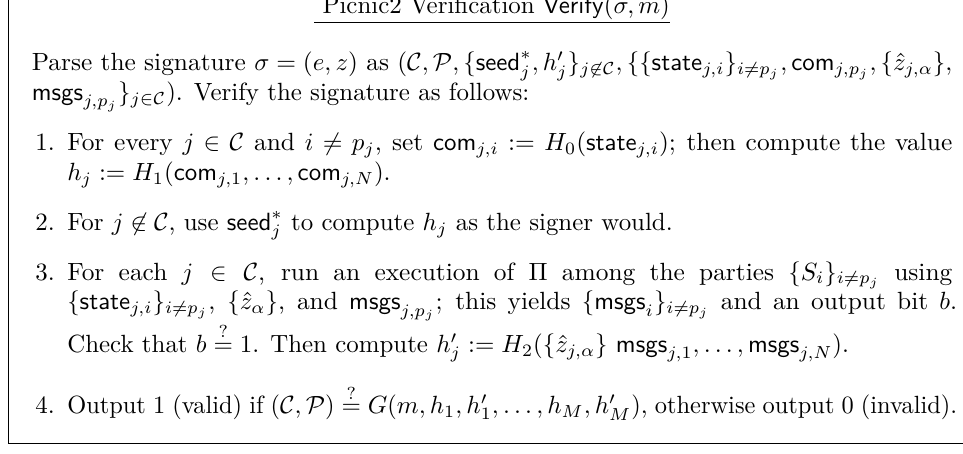
Figure 2: The verification algorithm in the Picnic2 signature